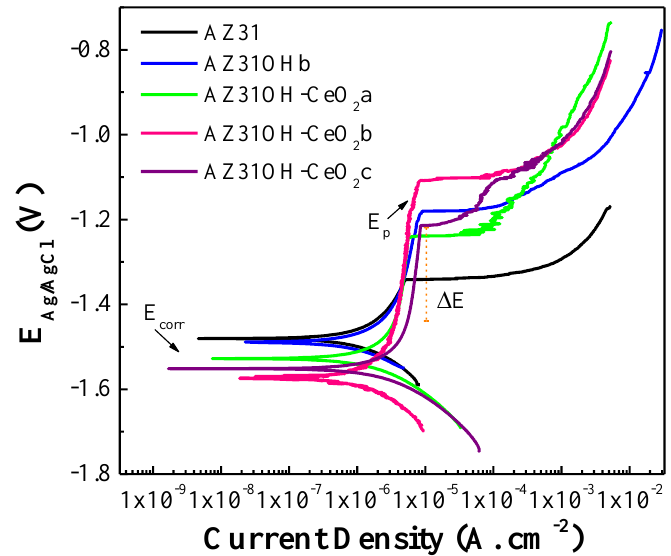
Figure 5. Polarisation curves of AZ31 and AZ31OHb (1 h anodised time) modified at different con- centrations of CeCl 2 after being anodised to form AZ31OH CeO 2 a, AZ31OH CeO 2 b, and AZ31OH CeO 2 c, at 0.001 M, 0.01 M, and 0.1 M, respectively. Table 6. Electrochemical parameter related to the polarisation curve of AZ31 anodised and modified at different concentrations of Ce 2+ ions.